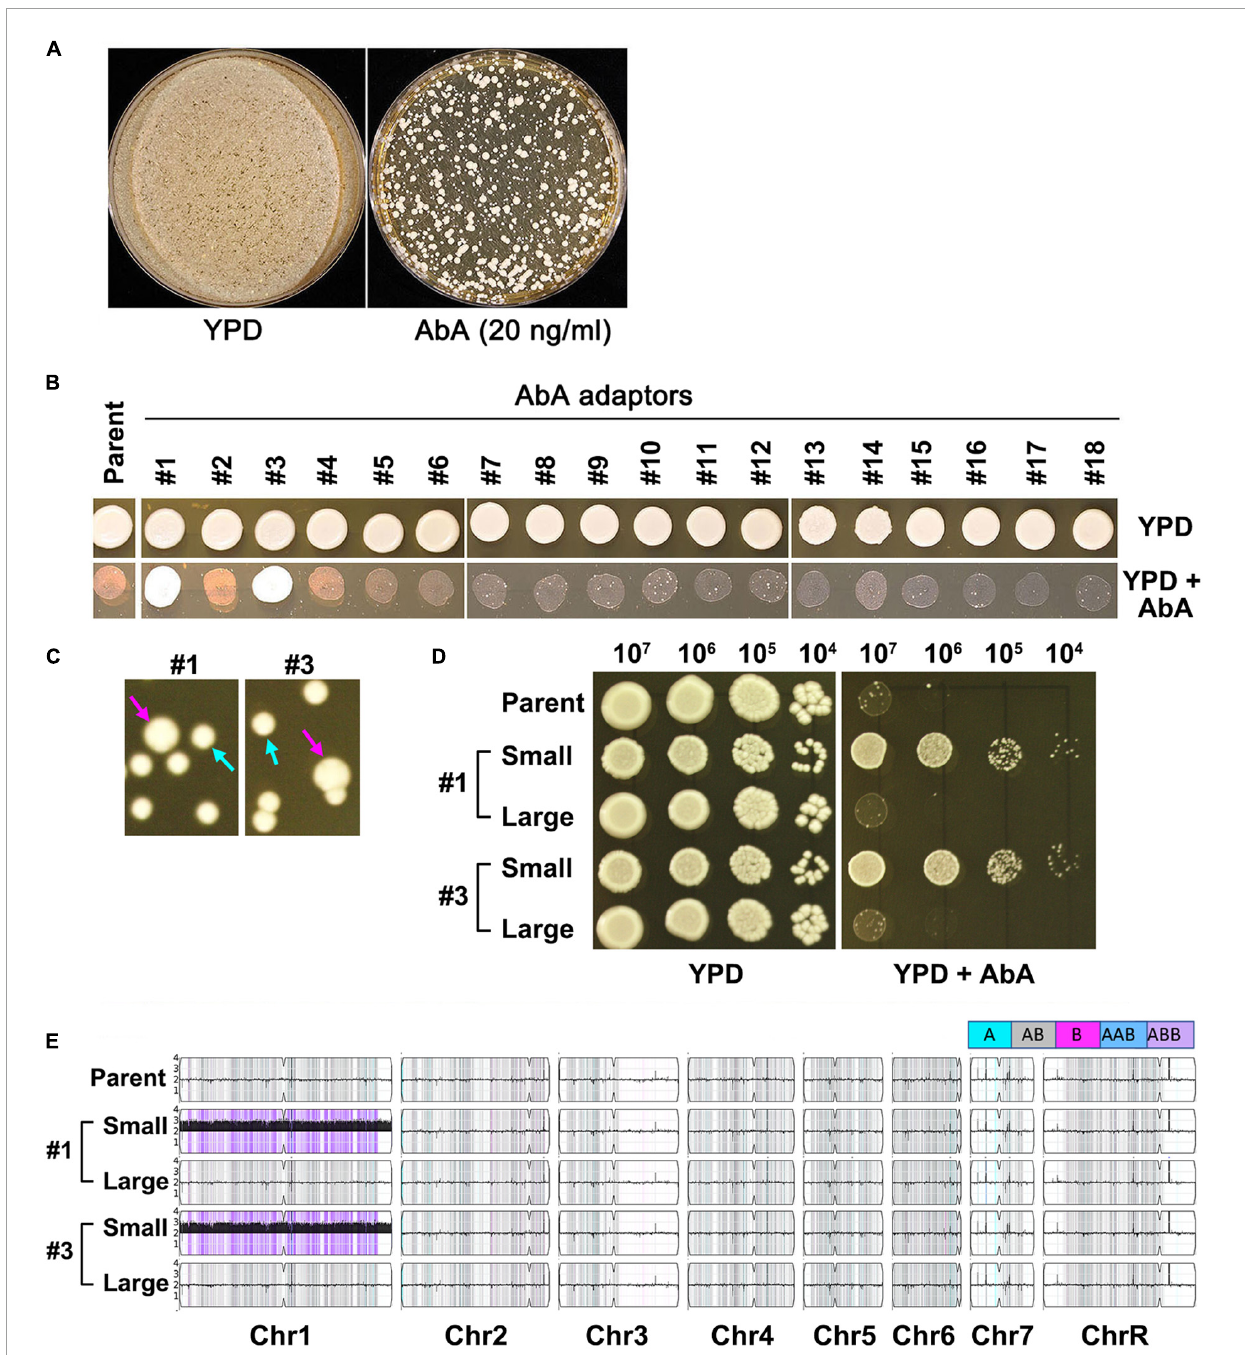
FIGURE2 Lethal amount of aureobasidin A selects unstable aneuploid mutants. Approximately 1 million cells of SC5314 were spread on YPD plate supplemented with 20 ng/ml aureobasidin A or without drug (control). The plates were incubated at 37 ◦ C for 3 days (A) . Randomly 18 mutants were chosen. Spot assay was performed to compare level of resistance between mutants and the parent (B) . Two resistant mutants (#1 and #3) were spread on YPD plates. Cyan arrows indicate small colonies and magenta arrows indicate large colonies (C) . Both small and large colonies were tested for resistance to aureobasidin A (D) and were sequenced (E) . The karyotypes were generated using Ymap (Abbey et al., 2014). Allele frequencies are color coded: homolog “a” is cyan, homolog “b” is magenta and heterozygous alleles are gray.